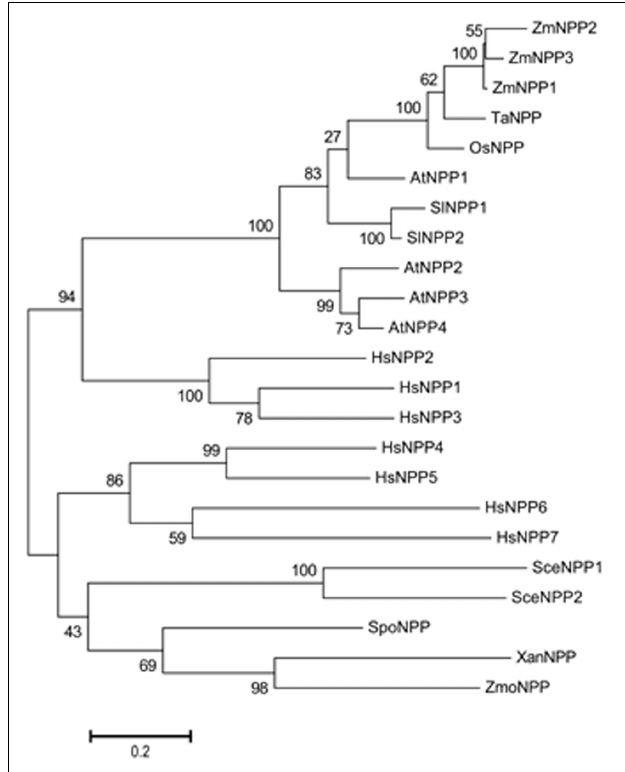
FIGURE 2 | Phylogenetic analysis of nucleotide pyrophosphatases/phosphodiesterases. The following sequences were collected: Xanthomonas XanNPP (WP_011051855.1), Zymomonas mobilis ZmoNPP (WP_011241358.1), Schizosaccharomyces pombe SpoNPP (O94323.1), Saccharomyces cerevisiae SceNPP1 (P25353.2), SceNPP2 (P39997.1), Zea mays ZmNPP1 (Zm00001d039454_P001), ZmNPP2 (Zm00001d047948_P001), ZmNPP3 (Zm00001d044311_P001), Oryza sativa OsNPP (LOC_Os01g10020.1), Arabidopsis thaliana AtNPP1 (AT4G29680.1), AtNPP2 (AT4G29690.1), AtNPP3 (AT4G29700.1), AtNPP4 (AT4G29710.1), Triticum aestivum TaNPP (ADK32530.1), Solanum lycopersicum SlNPP1 (Solyc07g037950.1), SlNPP2 (Solyc07g037960.1), Homo sapiens HsNPP1 (P22413.2), HsNPP2 (Q13822.3), HsNPP3 (O14638.2), HsNPP4 (Q9Y6X5.3), HsNPP5 (Q9UJA9.1), HsNPP6 (Q6UWR7.2) and HsNPP7 (Q6UWV6.3). The sequences were aligned using CLUSTAL W method (Thompson et al., 1994). The phylogenetic tree was built by the MEGA 6.0 software by the maximum likelihood method (Tamura et al., 2013). To estimate evolutionary distance, the proportions of amino acid differences were computed using Poisson Correction Distance. The reliability of different phylogenetic clusters was evaluated by the bootstrap test (1000 bootstrap